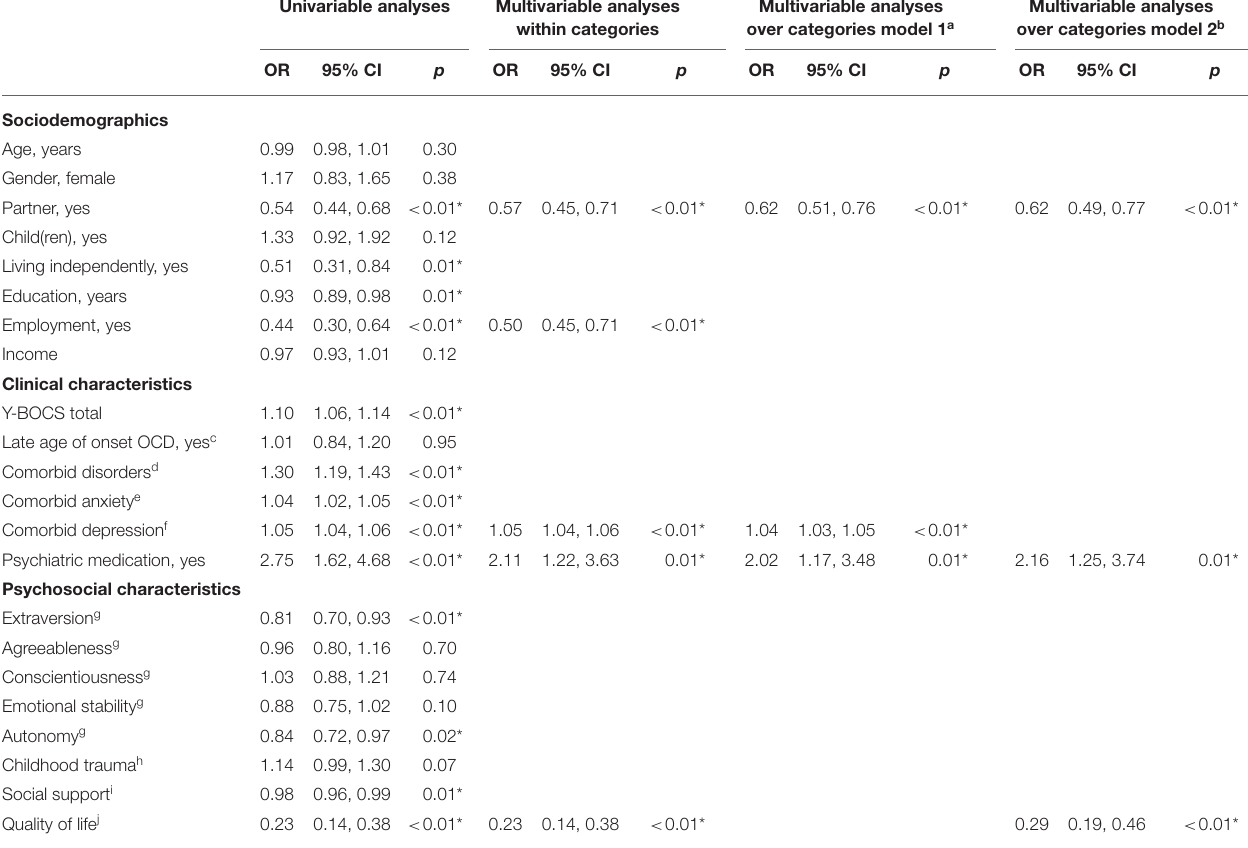
TABLE 3 | Results of logistic GEE analyses of potential predictors of intensive treatment 2 years later over a time-period of 6 years. Univariable analyses Multivariable analyses Multivariable analyses Multivariable analyses within categories over categories model 1 a over categories model 2